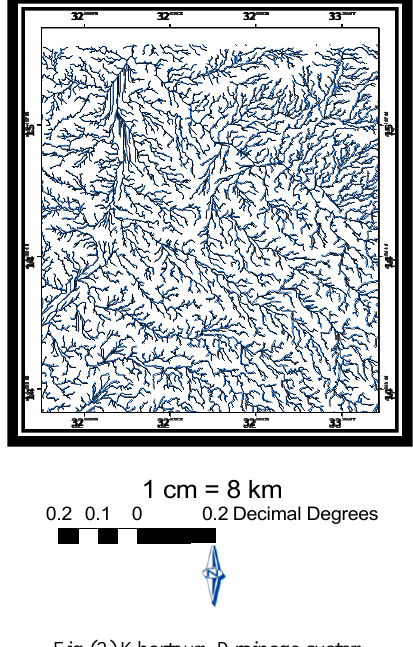
Fig (2) Khartoum Drainage